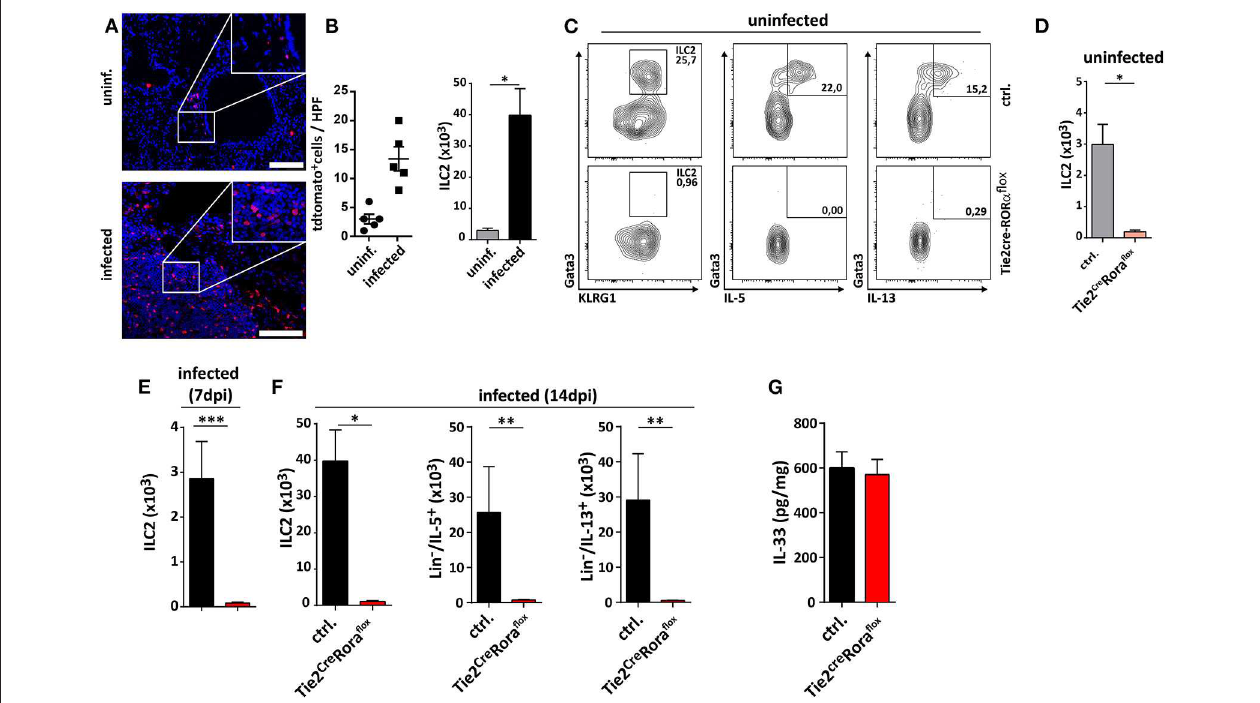
FIGURE 1 | Analysis of ILC2s in lungs of C. neoformans infected mice. (A,B,E–G) Mice were infected intranasally with 500 cfu C. neoformans. and analyzed 7 dpi (E) or (A,B,F,G) 14 dpi. (A) Representative IHC-pictures of lungs of Rora Cre tdTomato flox bone marrow chimeric mice and quantification of tdTomato expressing cells in naïve and Cryptococcus -challenged animals. (B) Pulmonary ILC2 counts of naïve and C. neoformans infected C57BL/6 mice ( n = 4–5/group). (C) Representative flow cytometric plots of lung Lin − /Thy1 + /Gata3 + /KLRG1 + ILC2, Lin − /Thy1 + /Gata3 + /IL-5 + ILC2 and Lin − /Thy1 + /Gata3 + /IL-13 + ILC2 of healthy controls and Tie2 cre Rora flox mice. (D) Quantification of naïve lung Lin − /Thy1 + /ICOS + /KLRG1 + ILC2 in control ( n = 4) and Tie2 cre Rora flox mice ( n = 4). (E,F) Quantification of Lin − /Thy1 + /ICOS + /KLRG1 + ILC2 ( n = 4), Lin − /IL-5 + (ctrl. n = 4, Tie2 cre Rora flox mice n = 6), and Lin − /IL-13 + (ctrl. n = 4, Tie2 cre Rora flox mice n = 6) populations in C. neoformans- challenged animals. (G) IL-33 concentration in lung tissue quantified per mg of total protein in control ( n = 18) and Tie2 cre Rora flox mice ( n = 26). Data is shown as mean ± SEM for at least two independent experiments. * P ≤ 0.05; ** P ≤ 0.01 and *** P ≤ 0.001 using a Mann-Whitney U